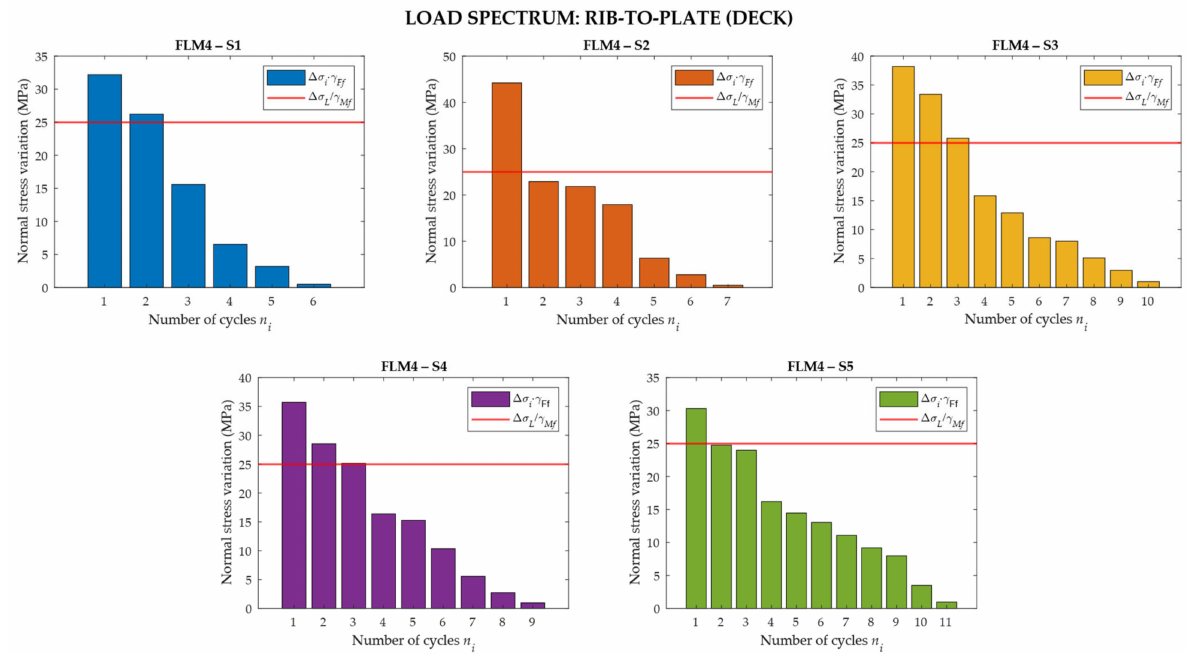
Figure 28. Tension load history for the transit of the five lorries from the FLM4.